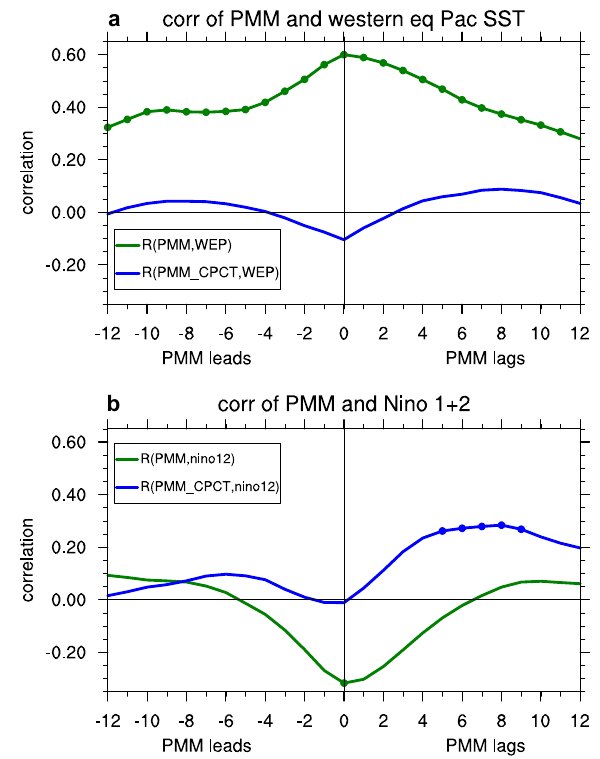
Fig. 2 Incomplete ENSO removal in the reference PMM-T index. a Lagged regressions of SST in the western equatorial Paci fi c (150°W-180°, 5°S-5°N) for the reference PMM-T index (green line) and the PMM_CPCT (blue line), which uses a more through method for removing ENSO prior to the PMM calculation. Negative lags indicate that the PMM leads the SST index and vice versa. Values that are statistically signi fi cant at the 95% level, based on a two- tailed Student ’ s t -test, are marked by a fi lled circle. b Like ( a ), but for the Niño 1 + 2 index (SST averaged over 90°-80°W, 10°S-0°). All fi elds are from the NCEP/NCAR